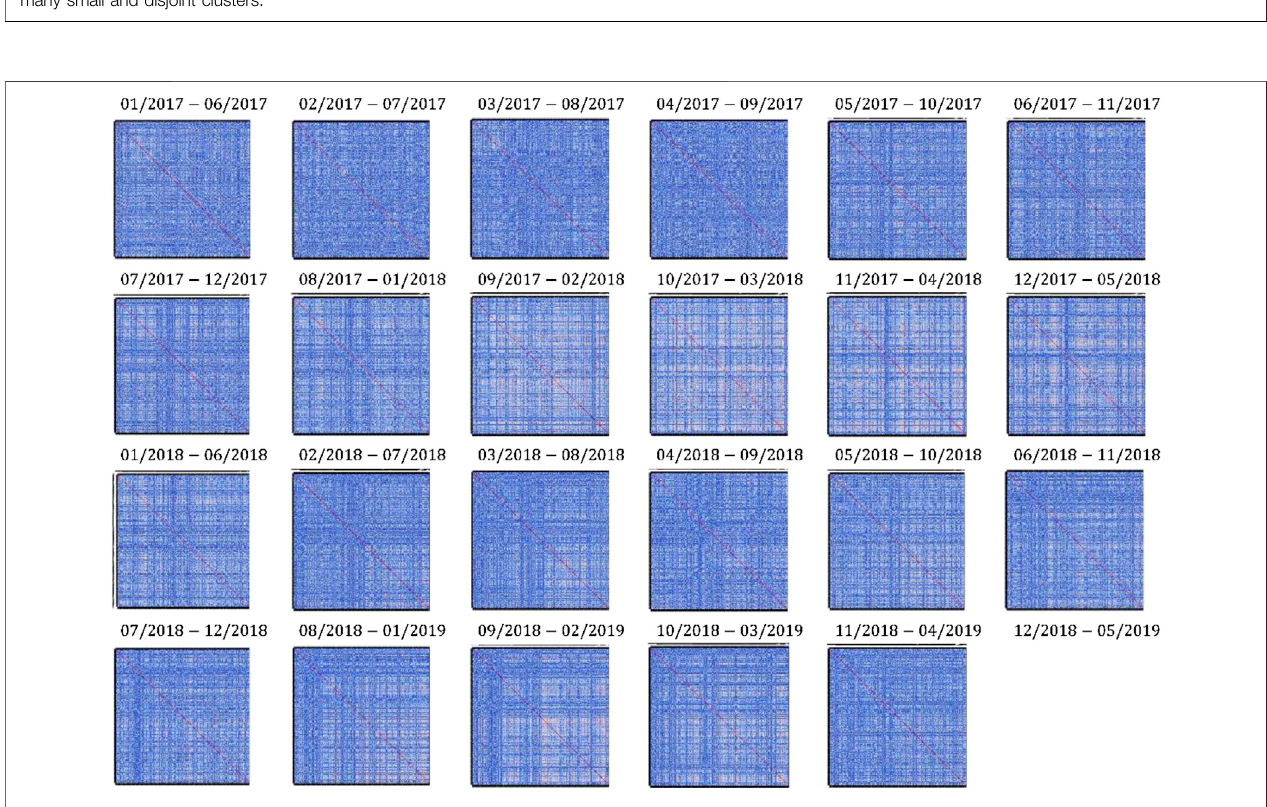
FIGURE 8 | The correlation matrices of STI from Jan 2017 to Apr